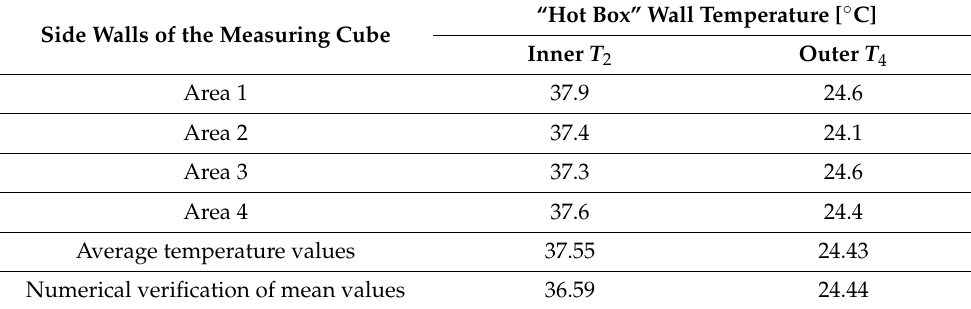
Table 2. Summary of temperature measurement results on the inner and outer walls of the “hot box” measuring cube.